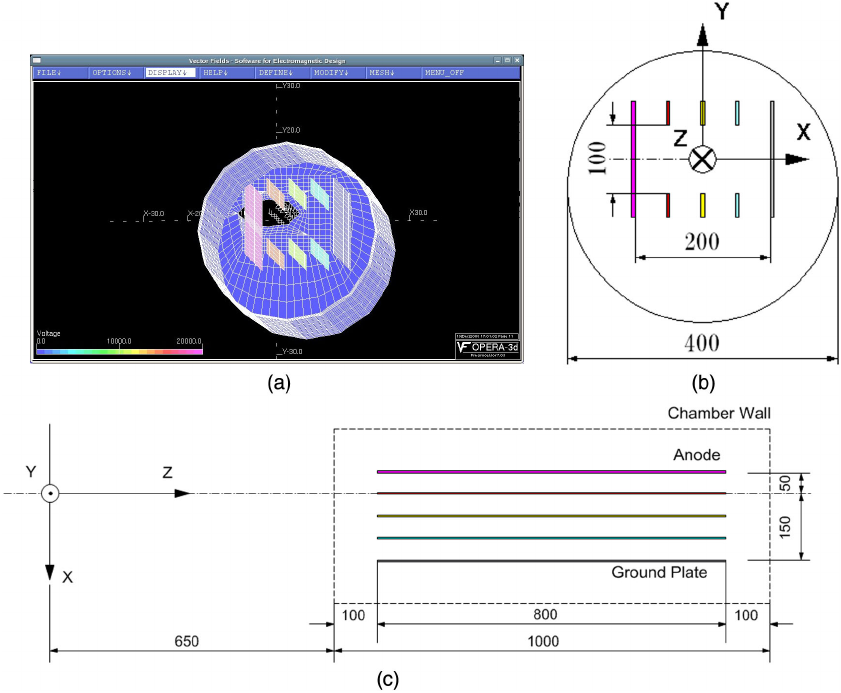
FIG. 5. (a) TOSCA model of the ES-Kicker. (b) Front view of the ES-Kicker (unit:mm). (c) Top view of the ES-Kicker (unit:mm).